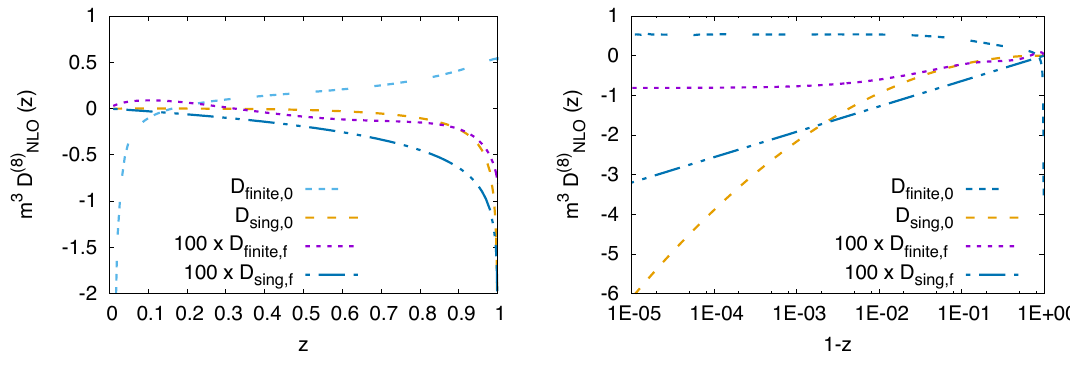
Figure 4 . The singular contributions D (8) ( z ) and the remaining (cid:12)nite contributions D (8) ( z ) to sing (cid:12)nite the NLO fragmentation function. The same curves are shown as a function of z with a linear scale (left panel) and as a function of 1 (cid:0) z with a logarithmic scale (right panel). In the labels for the curves, a subscript 0 indicates the n f = 0 term and a subscript f indicates the term from one additional light-quark